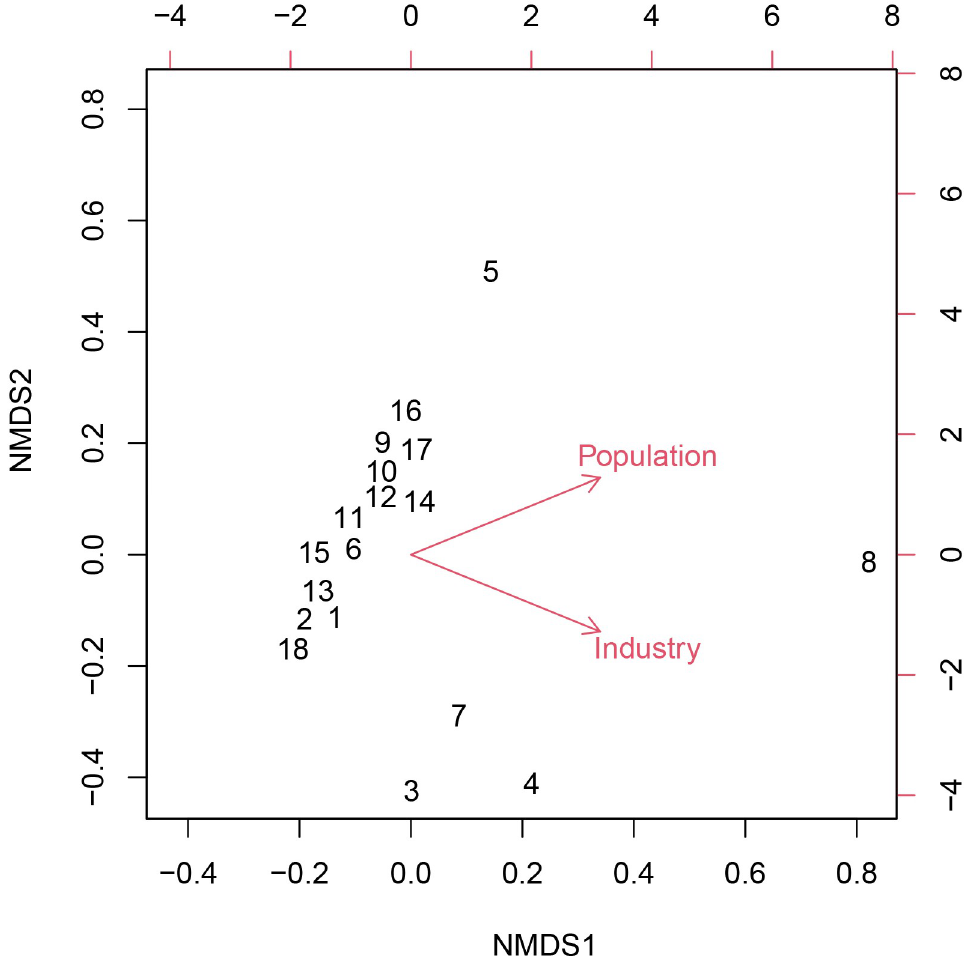
Fig 4. Results of non-metric multidimensional scaling (NMDS) analyses of the endemic species of 18 administrative units and the environmental variables. Industry = industrial revenue.